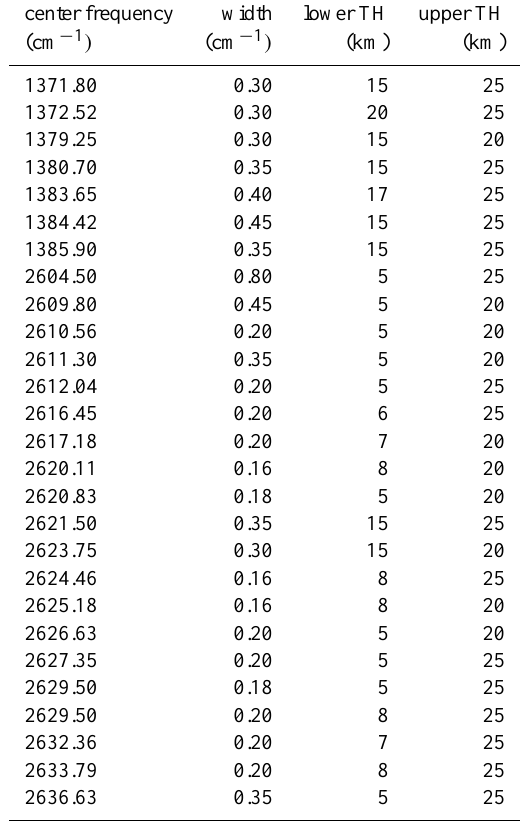
Table 1. N 2 CIA microwindows: Center frequencies, widths, and tangent height ranges in order of increasing lower TH limit.